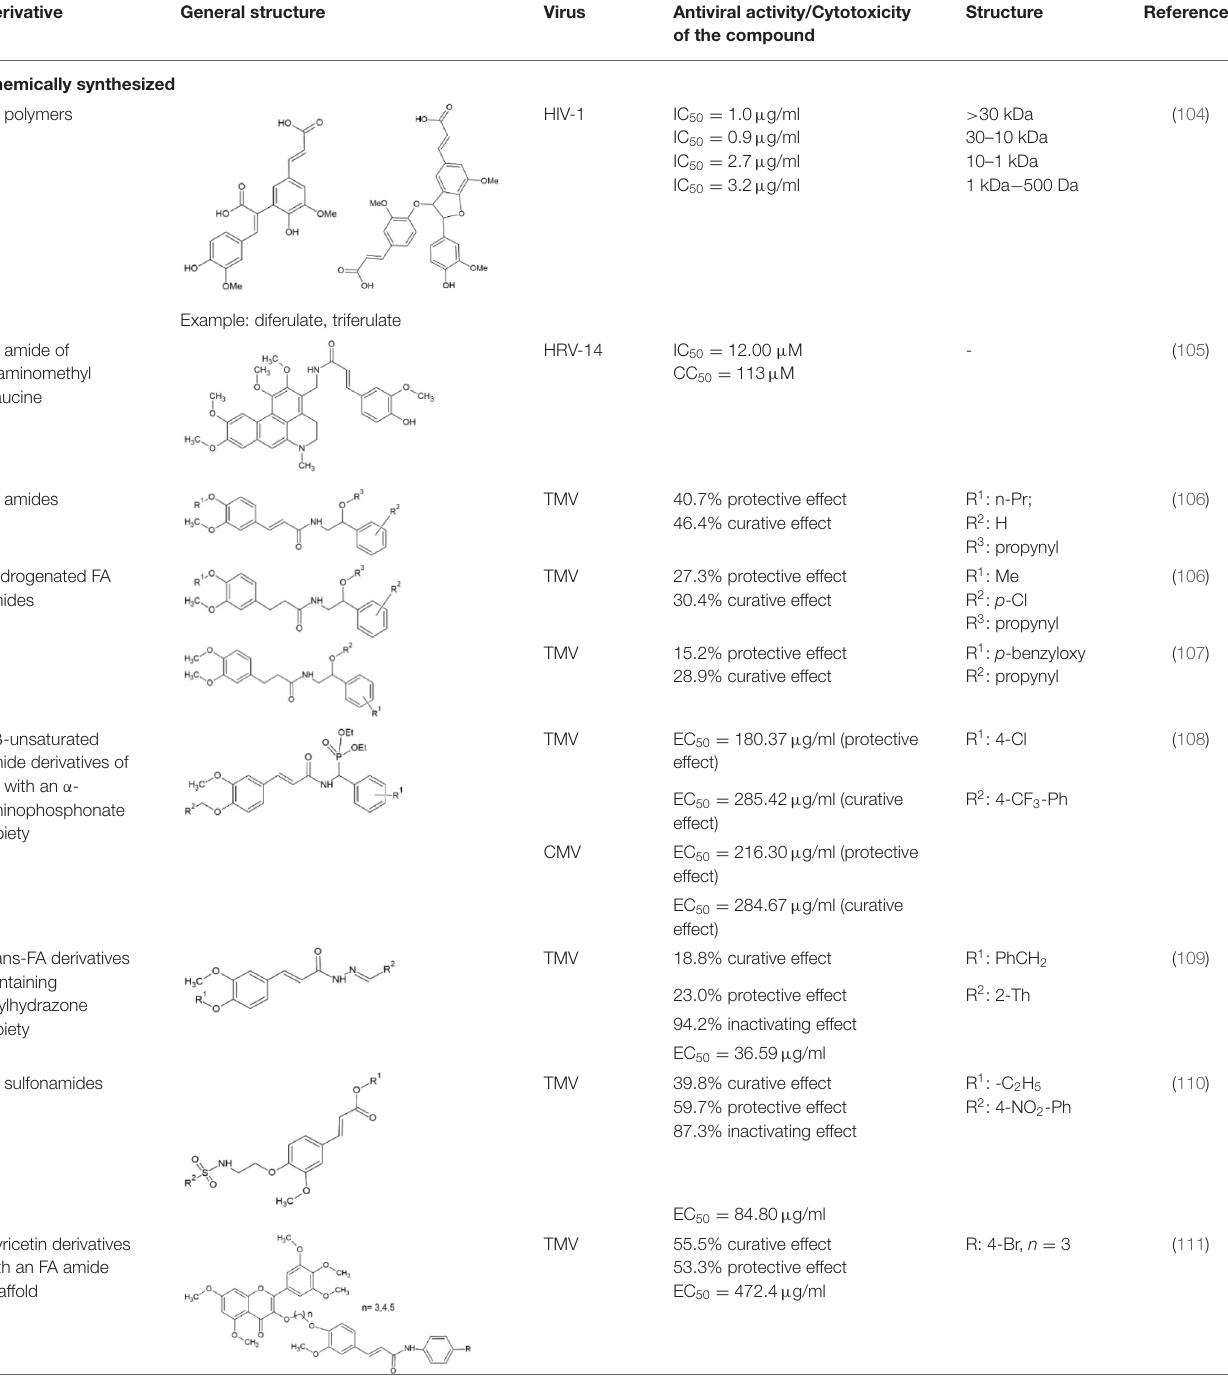
TABLE 3 | Antiviral effect of FA